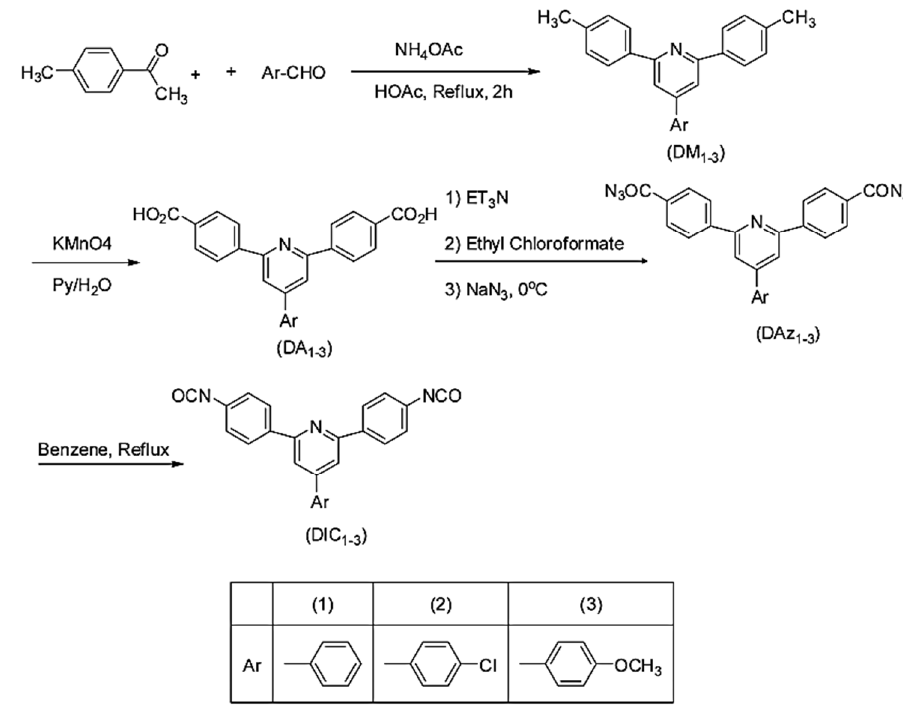
Figure 22. Synthesis route of the oligoaniline and EPU. From reference [51].